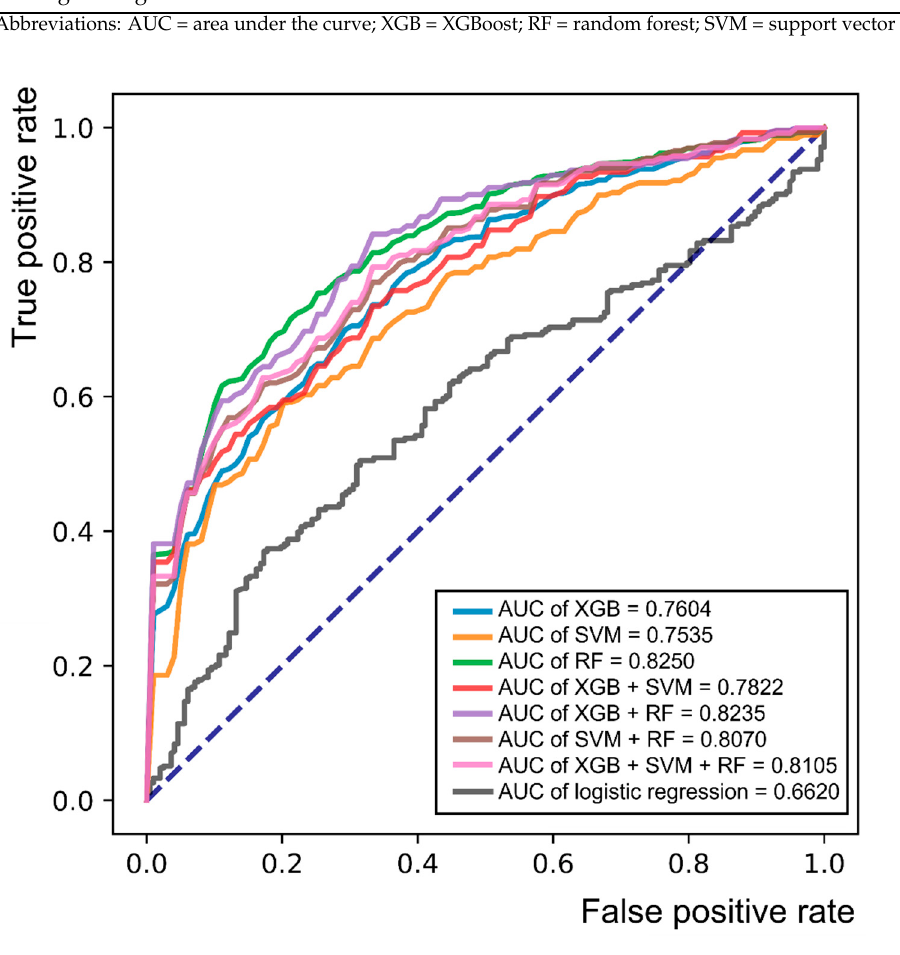
Figure 3. Receiver operating characteristic (ROC) curve for single or combinations of various ma- chine learning algorithms and logistic regression analysis in the classification of the combination of the normal, possible, and probable groups versus the confirmed group. Abbreviations: AUC = area under the curve; XGB = XGBoost; RF = random forest; SVM = support vector